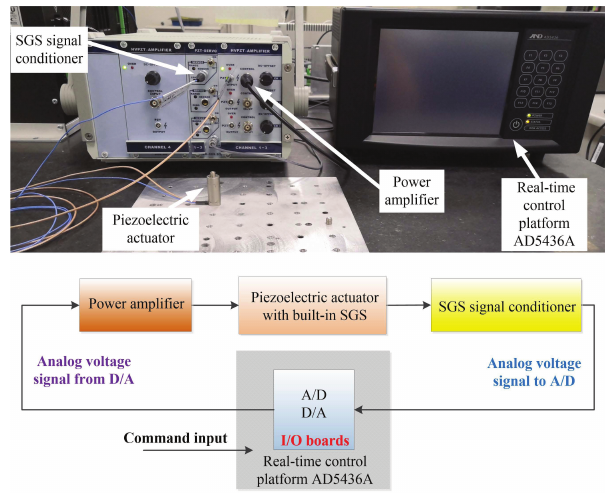
Figure 1. Experimental platform: ( top ) main hardware including piezoelectric actuator, power amplifier, strain gauge sensor signal conditioner, and real-time control platform AD5436A, ( bottom ) signal